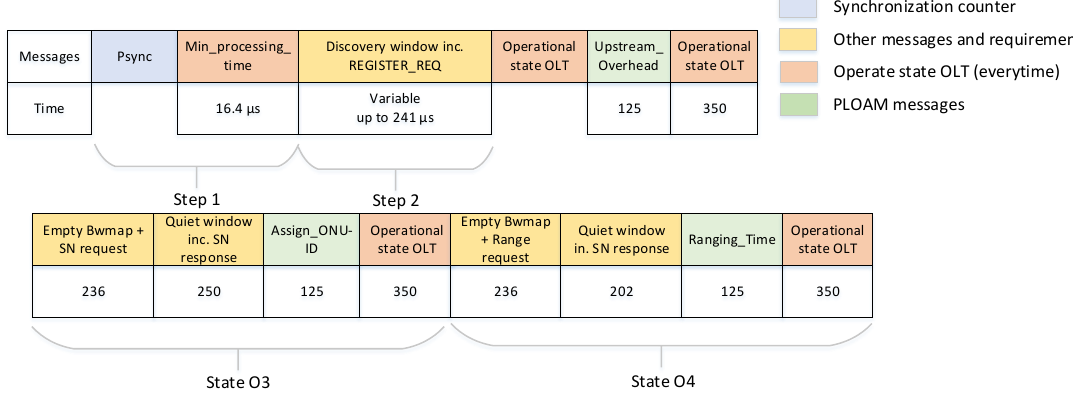
Figure 10. Graph of activation time for GPON ( left ) and optimized GPON ( right ) 32/64 units and Figure 3. Graph of activation time for GPON 32/64 units and 20 km ODN. Figure 4. gponOPT 20-km ODN.